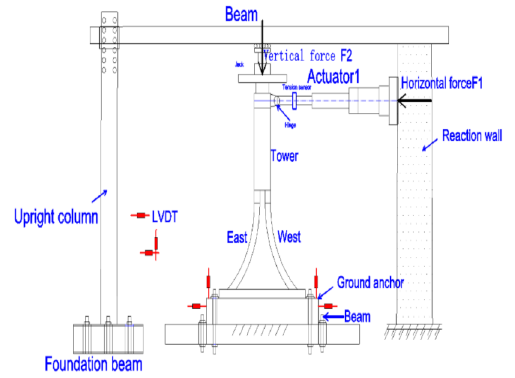
Figure 5. Test setup of specimen under cyclic loading.